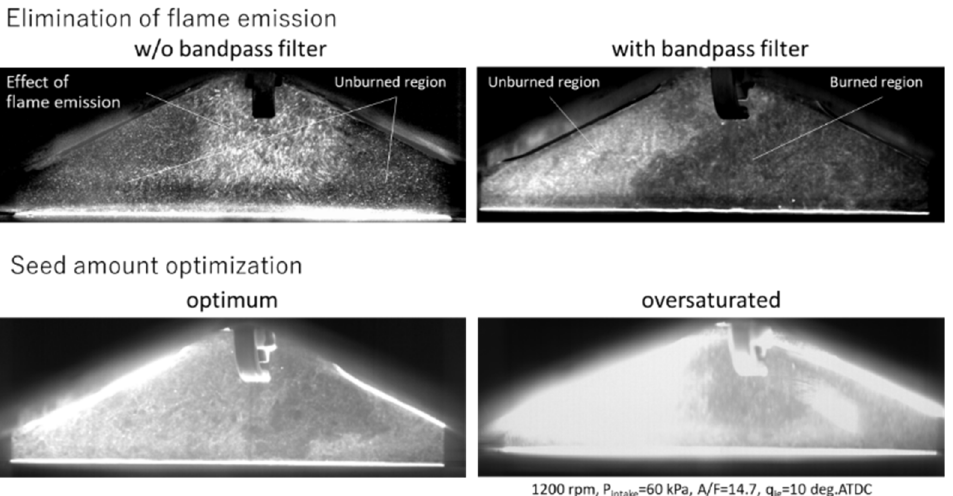
Figure 5. Seeding particle images in combustion flow.